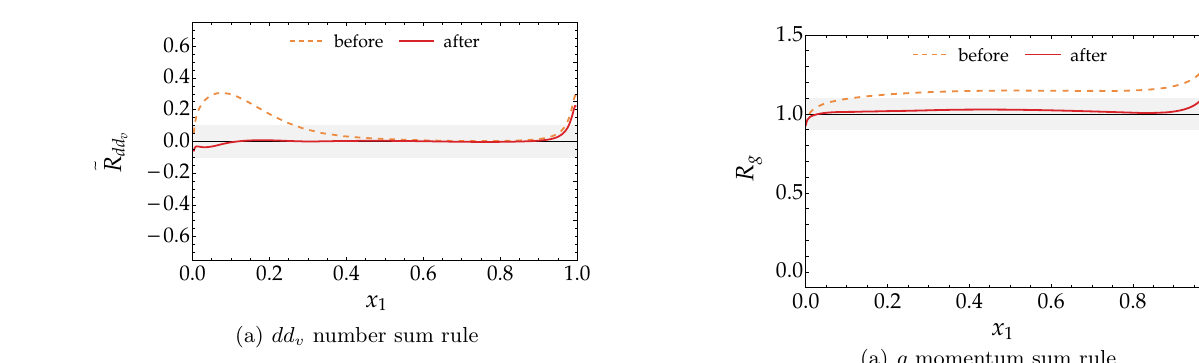
Fig. 12 Change of the gluon momentum sum rule due to the modifi- cation of the g → gg splitting at large y